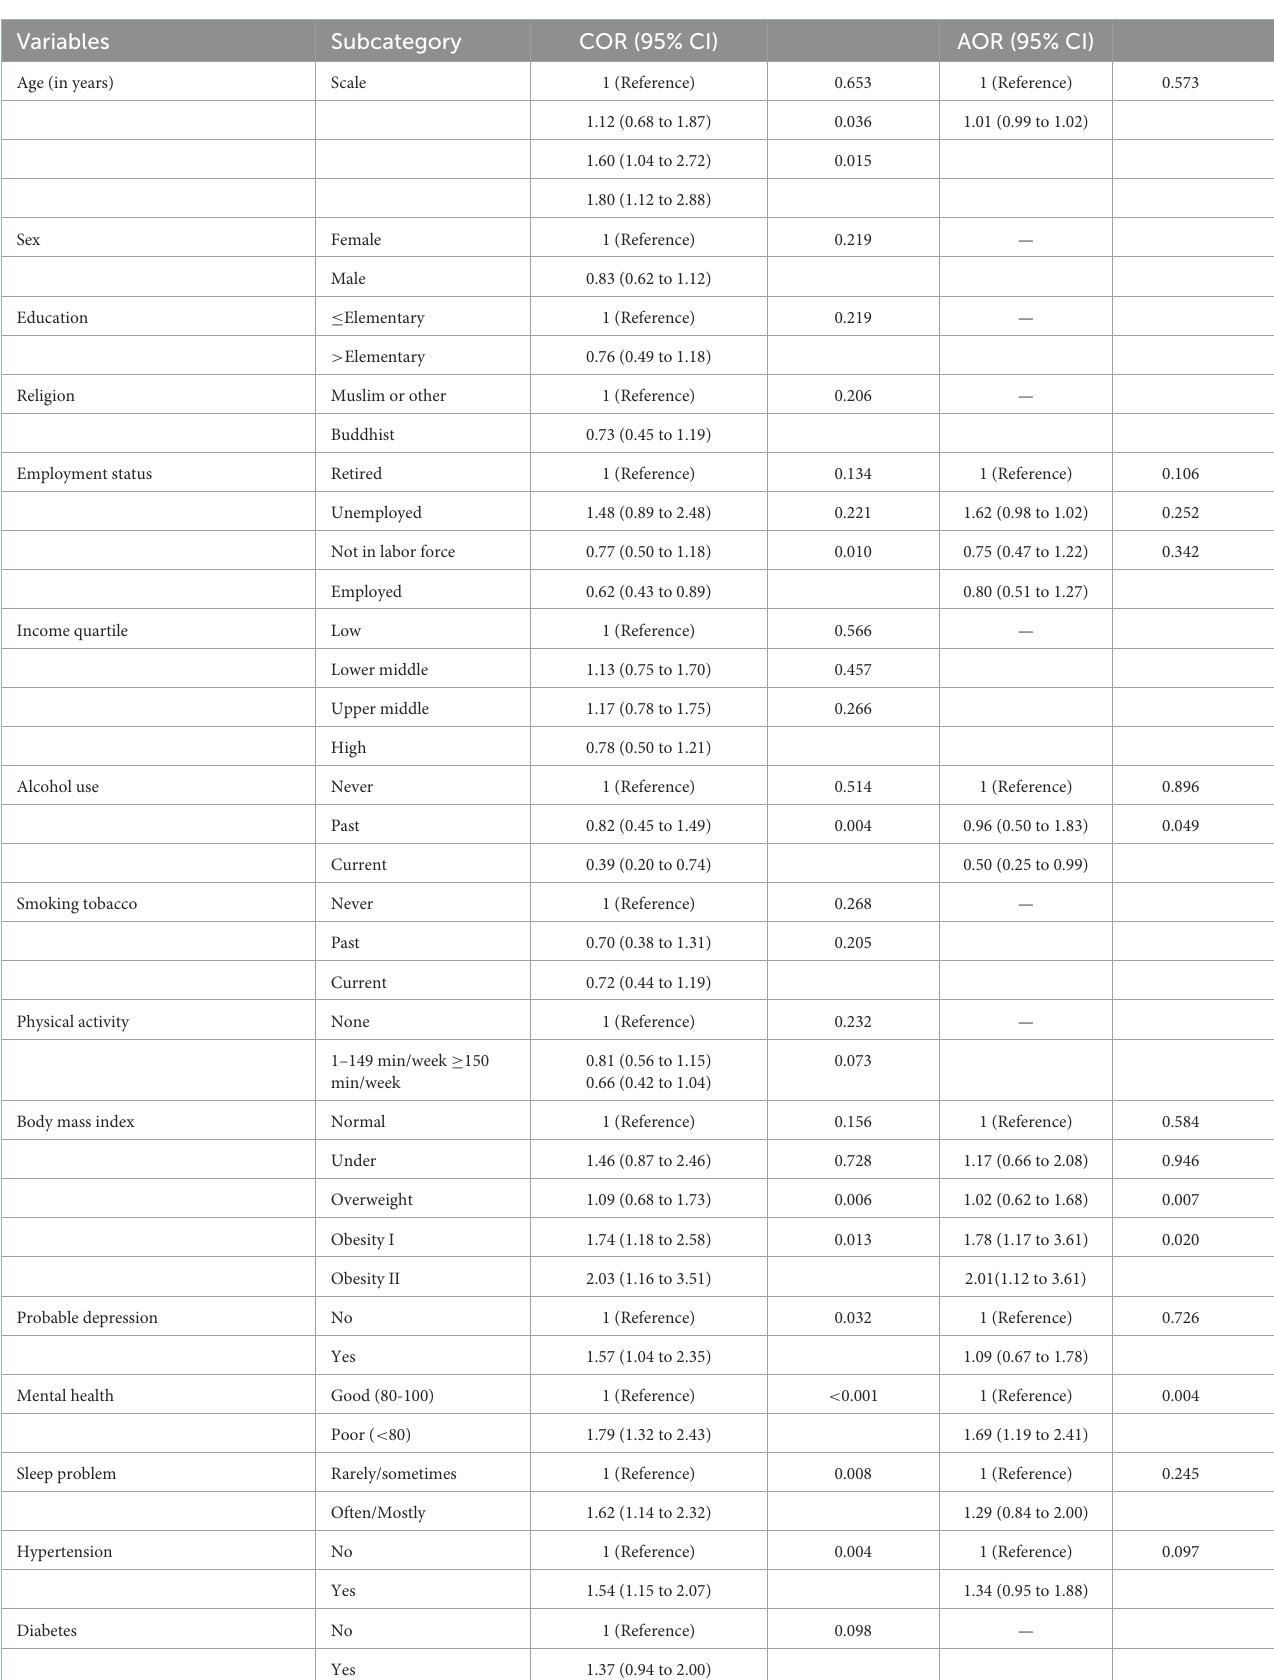
TABLE 3 Longitudinal associations with incident arthritis, HART